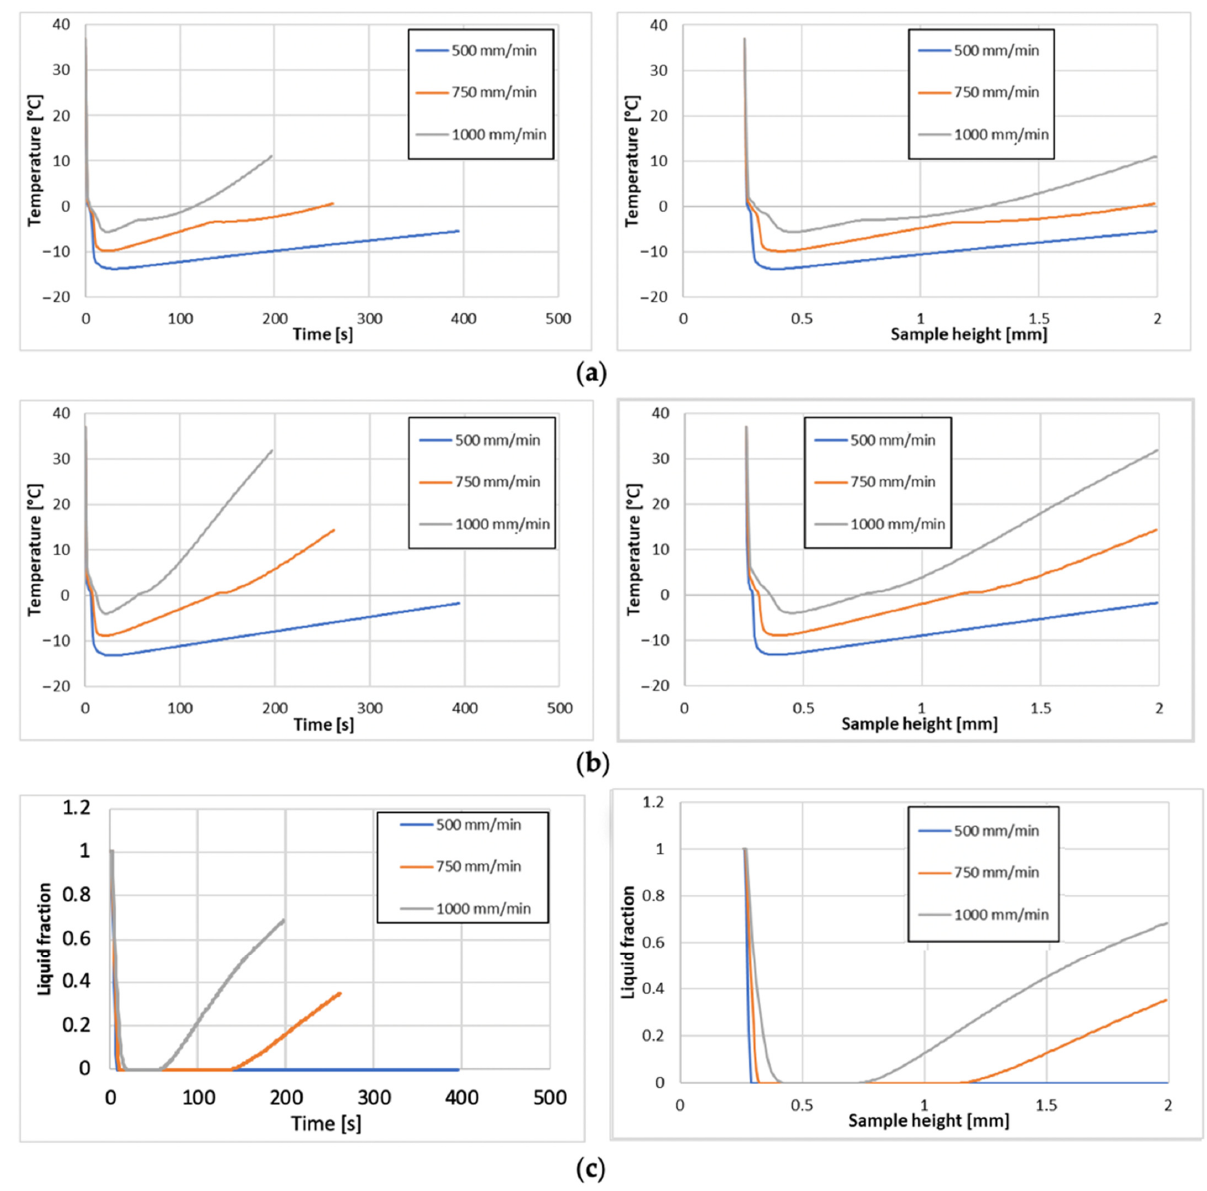
Figure 6. Average temperature ( a ), the average temperature at the top surface ( b ), and an average liquid fraction ( c ) of the bioprinted sample during the printing time (left graphs), or printing sample height (right graphs).